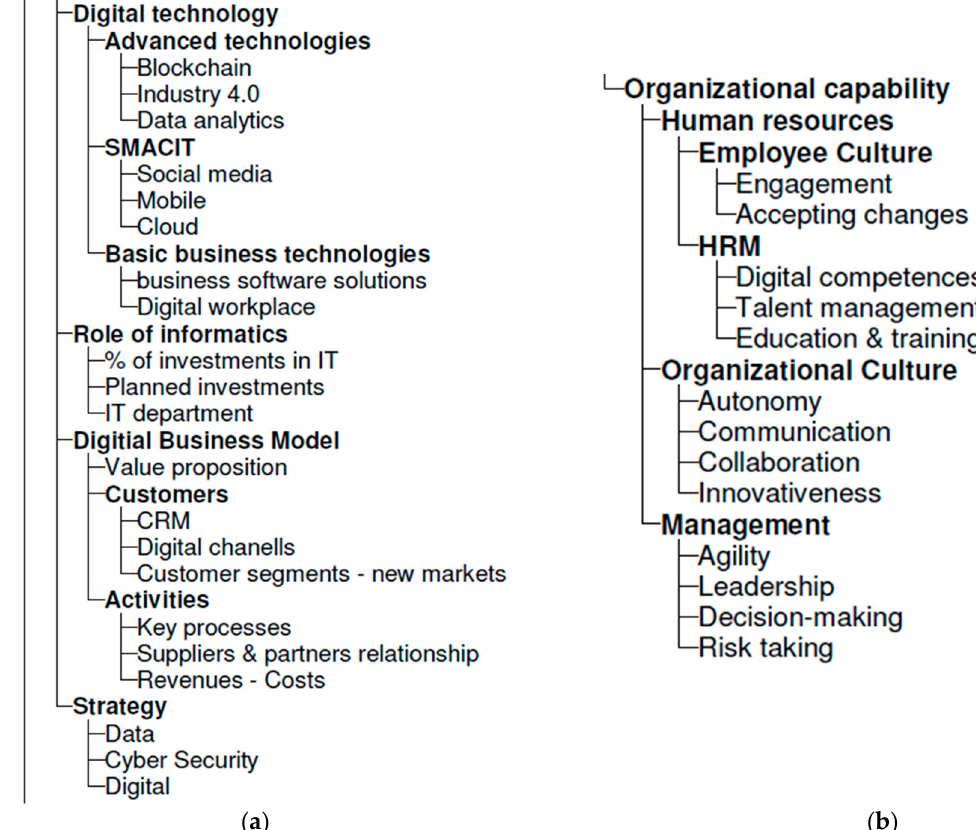
Figure 2. The hierarchical tree of attributes: ( a ) subtree for dimension digital capability and ( b ) subtree for dimension organizational capability.